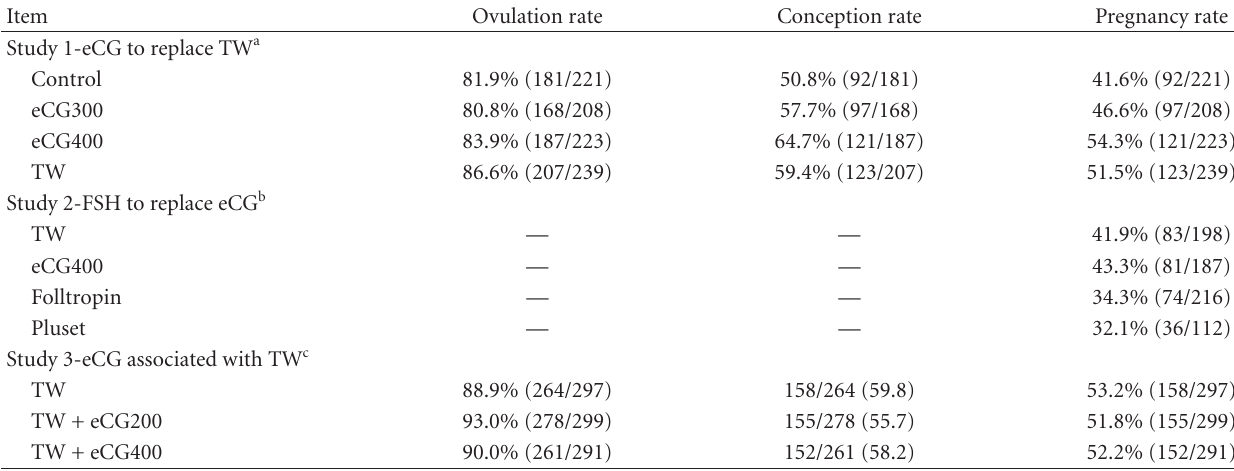
Table 3: Ovulation, conception, and pregnancy rates of suckled Bos indicus cows submitted to a synchronization of ovulation protocol using progesterone associated with estradiol having di ff erent strategies to improve fertility. Adapted from S´a Filho et al.